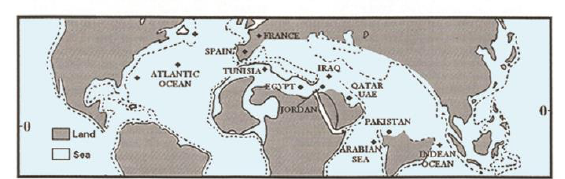
Figure 1: Paleogeographic map of Maastrichtian showing locations of some countries in the Tethys, i.e. Tunisia, Egypt, Jordan,